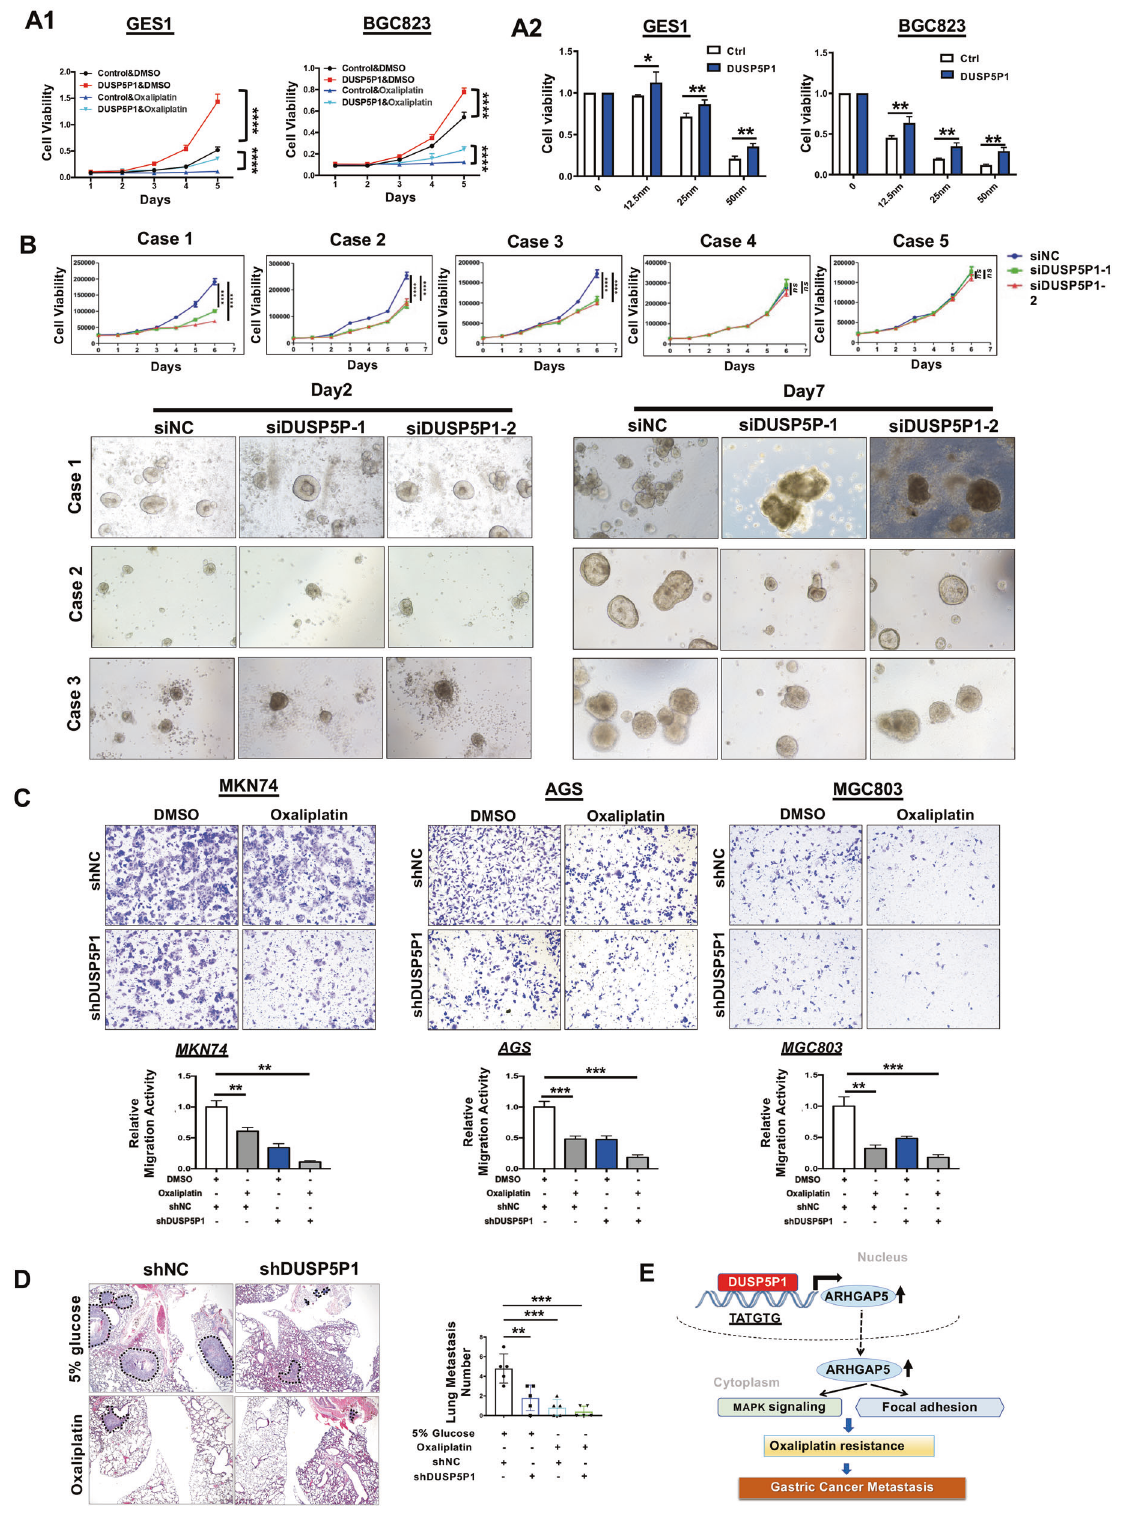
Fig. 6 DUSP5P1 is a potential therapy target in platinum drugs resistant GC cells. A DUSP5P1 transfected GC cells was partially resistant to the chemotherapy effect of Oxaliplatin by MTT assay. B DUSP5P1 Knockdown suppressed the GC PDO cell growth in the three of fi ve platinum drugs resistant models. C Combination therapy of Oxaliplatin and DUSP5P1 depletion signi fi cantly inhibited the migration of the GC cells. D Representative HE staining image of the lung metastasis revealed metastasis synergistic inhibiting effect of Oxaliplatin and DUSP5P1 depletion in vivo. E Proposed mechanistic scheme of DUSP5P1 promoting the GC progression. DUSP5P1 promoted the expression of ARHGAP5, by directly binding to promoter region, which further promotes the activity of focal adhesion and MAPK signaling pathway. * P < 0.05, ** P < 0.01, *** P < 0.001, **** P <